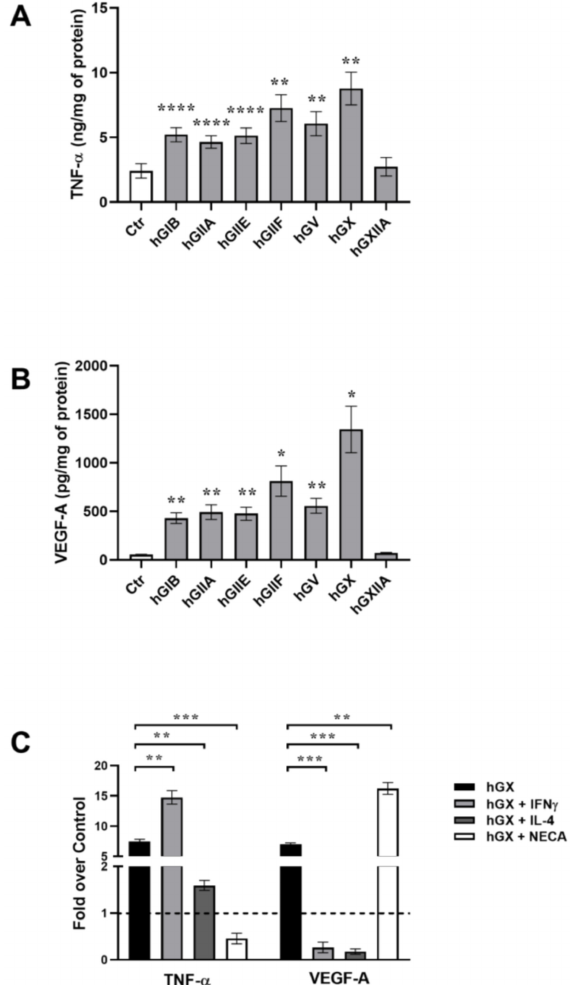
Figure 1. Different human-secreted phospholipase A2 enzymes (sPLA 2 ) isoforms activate human lung macrophages (HLMs). HLMs were incubated (37 ◦ C, 18 h) in RPMI 1640 containing human recombinant group IB (hGIB), group IIA (hGIIA), group IIE (hGIIE), group IIF (hGIIF), group V (hGV), group X (hGX), and group XIIA (hGXIIA) sPLA 2 s (kindly donated by G. Lambeau or M.H. Gelb). At the end of incubation, the supernatants were harvested, centrifuged (1000 × g , 4 ◦ C, 5 min) and stored at − 80 ◦ C for subsequent analyses. Tumor necrosis factor- α (TNF- α ) ( A ) and vascular endothelial-derived growth factor-A (VEGF-A) ( B ) concentrations were determined by ELISA and values were normalized for the total protein (measured by Bradford assay) content in each well. The data are reported as the mean ± SEM of four different preparations of HLMs from four different donors. One-way ANOVA and Dunnett’s post test. * p < 0.05, ** p < 0.01, **** p < 0.001. vs. control. ( C ) Pro-inflammatory and angiogenic profiles in hGX-induced HLMs are differentially modulated by interferon- γ (INF- γ ), interleukin (IL)-4, and 5 (cid:48) -(N-Ethylcarboxamido) adenosine (NECA). HLMs were with INF- γ (1000 U/mL—light gray bars), IL-4 (10 ng/mL—dark grey bars), or NECA (10 µ M—white bars). At the end of incubation, the supernatants were harvested, centrifuged (1000 × g , 4 ◦ C, 5 min) and stored at − 80 ◦ C for subsequent analyses. TNF- α and VEGF-A concentrations were determined by ELISA and values were normalized for the total protein (measured by Bradford assay) content in each well. The data are reported as fold increase over control (unstimulated cells, dotted line), as the mean ± SEM of four different preparations of HLMs from four different donors. One-way ANOVA and Dunnett’s post test. * p < 0.05, ** p < 0.01, *** p < 0.005. vs.